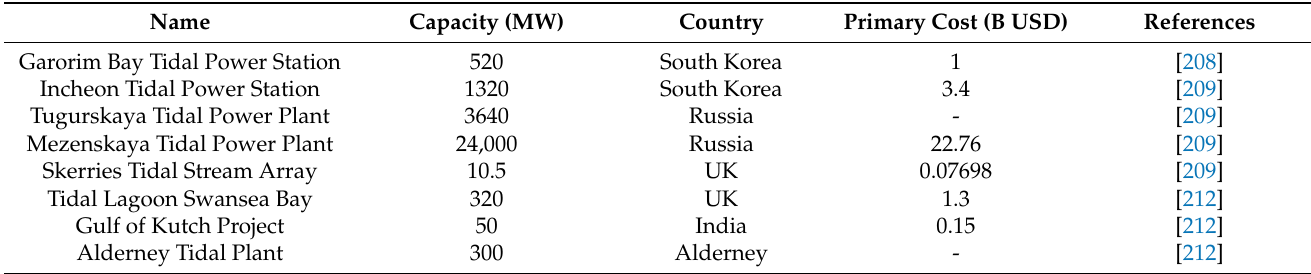
Table 11. Globally planned tidal power